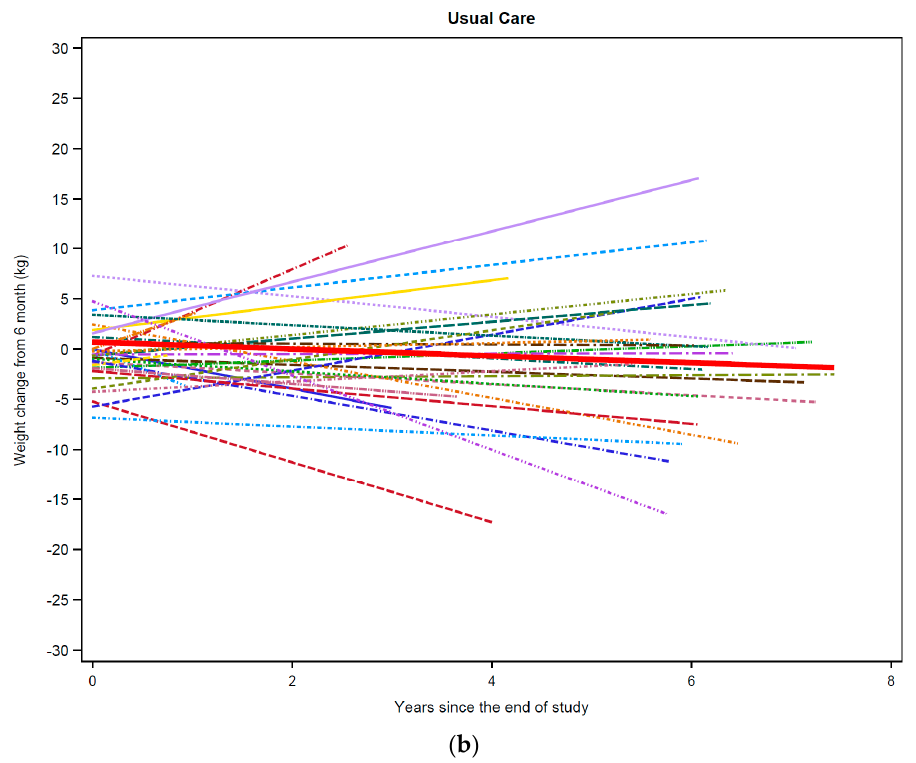
Figure 1. Weight trajectories by study group. Weight trajectories for each individual participant from LEAN Study completion through long-term follow-up (latest date July 2019) are shown: ( a ) intervention group ( n = 60); ( b ) usual care ( n = 32). The thick red line in ( a ) corresponds to the mean weight trajectory among intervention group participants, and the thick red line in ( b ) corresponds to the mean weight trajectory among usual care group participants.